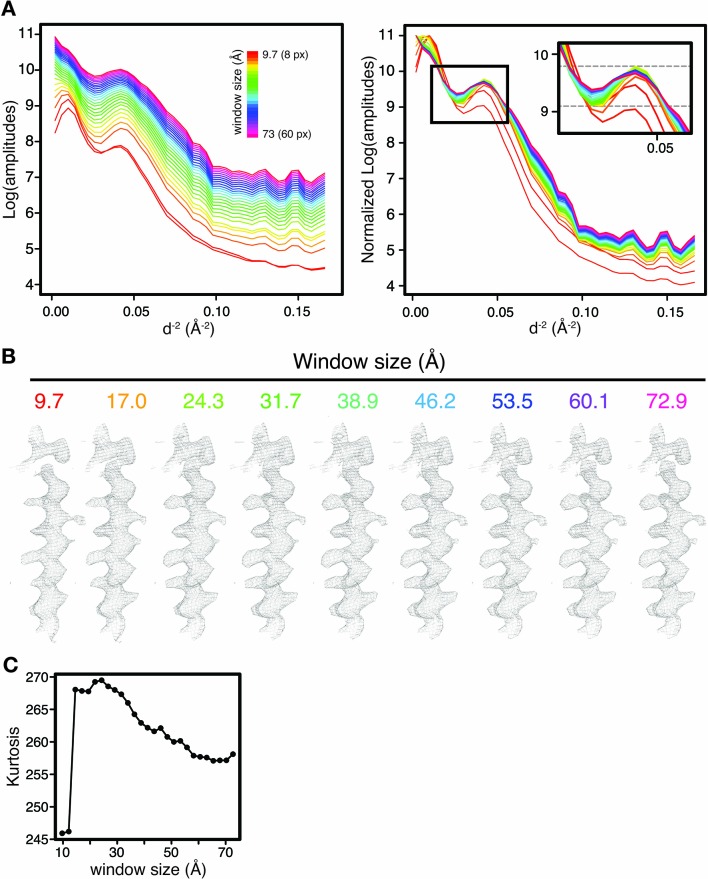
Effect of window size on local reference-based sharpening.(A) Guinier plot of TRPV1 density (EMD-5778) obtained after LocScale sharpening with PDB 3j9j for window size ranging from 8 to 60 pixels (9.7–73 Å). (Left) Guinier profiles are colored in rainbow colours by window size as indicated. Note the increase in absolute scattering at zero spatial frequency with increasing window size. Also note the decreased amplitude at low resolution for small window sizes. (Right) Same profiles as shown left, scaled to the absolute frequency for the largest window, permitting comparison of Debye effect region at 7–4 Å (inset). The magnitude of the Debye effects first increases, then decreases with increasing window size. (B) LocScale densities for the V430-F449 transmembrane helix of TRPV1 shown for a selection of window sizes from (A). (C) Map kurtosis computed for the LocScale maps in (A). Kurtosis peaks for window sizes between 20–35 Å, corresponding to the range for which also Debye effects in (A) are found to be strongest.